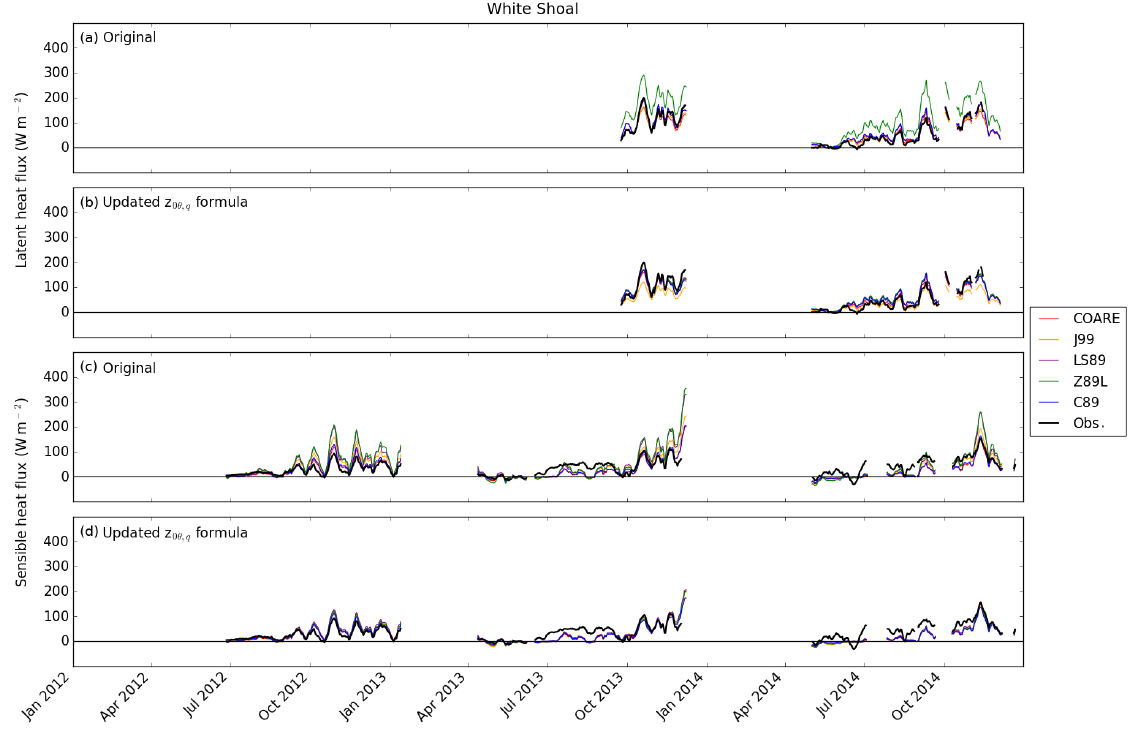
Figure 5. The same as Fig. 4, but at White